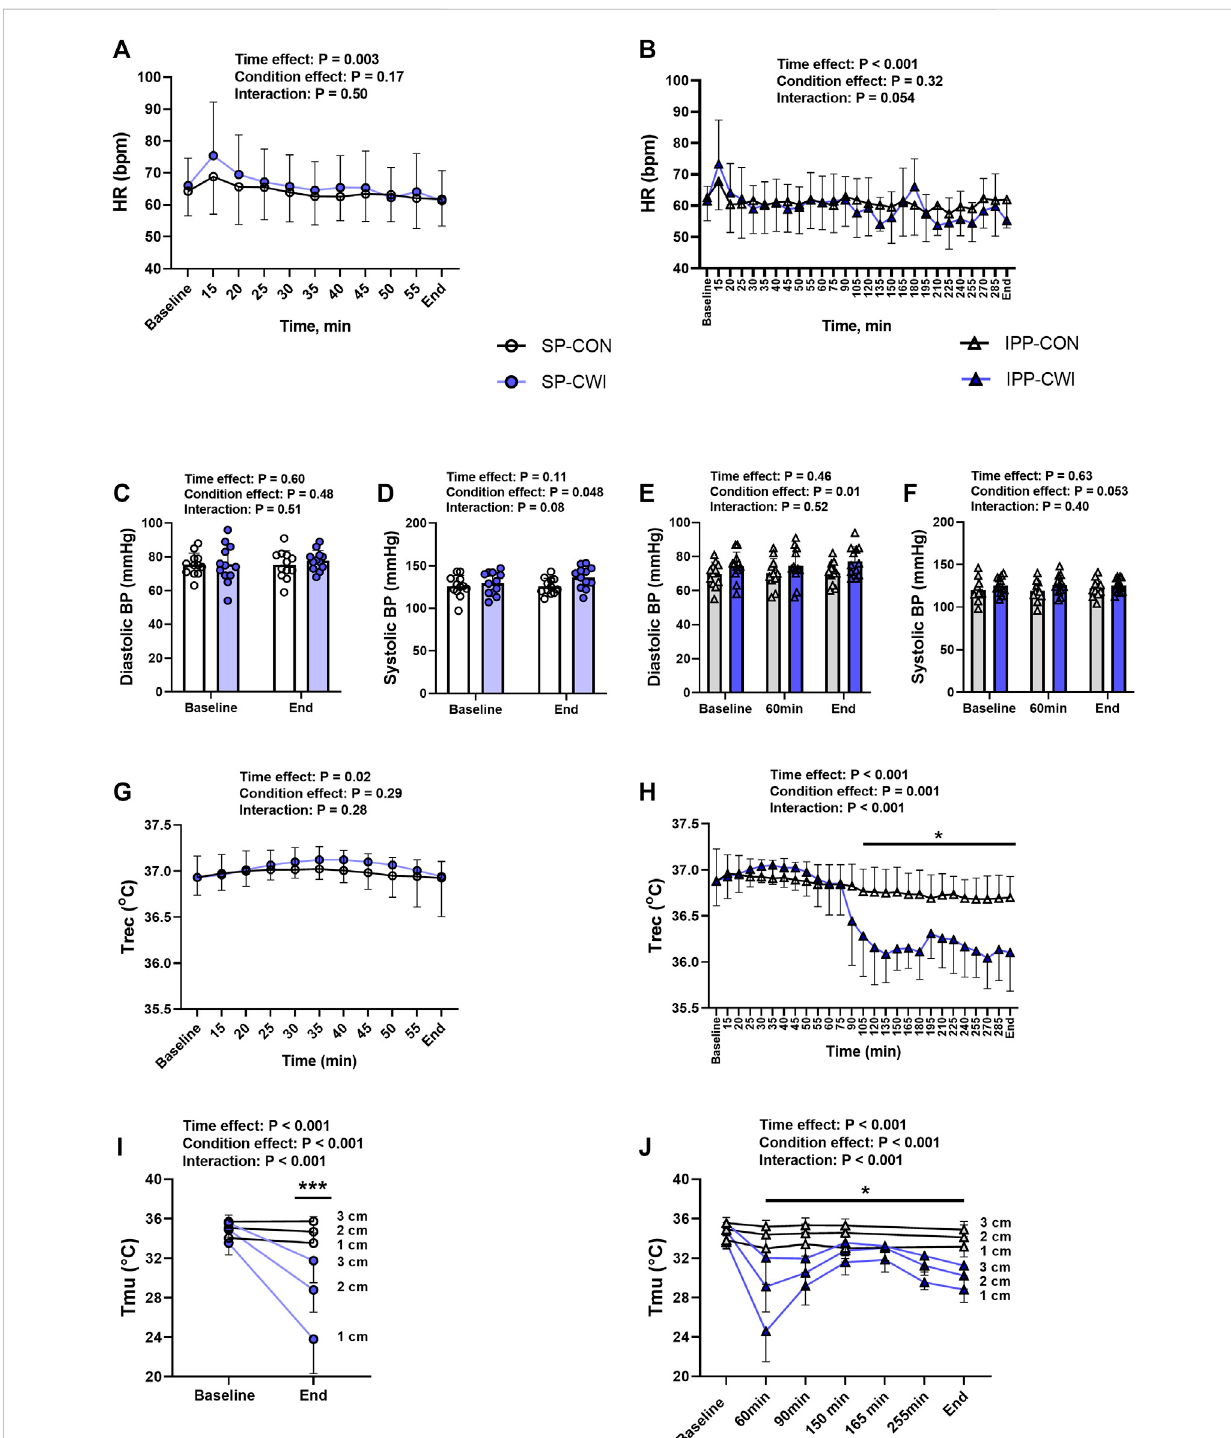
FIGURE 2 Physiologicalmeasurementsduringthesingleandintermittent/prolongedphases.Heartrate(HR) (A,B) ,diastolic (C,E) andsystolic (D,F) bloodpressures (BP), rectal temperature (Trec) (G,H) and intramuscular temperature (Tmu) at three depths (1, 2, and 3 cm) (I,J) during the single and intermittent/prolonged phases, respectively. Dataare shown asmean± SDand individualvaluesare presentedin panels C – F.SP,single phase;IPP, intermittent/prolongedphase.*, p < 0.05; ***, p < 0.001: Signi fi cant differences CON vs. CWI. In I and J, signi fi cant differences are between CON and CWI are at the three depths. In J, Tmu was not assessed in CON at the time points 165 and 255 min. N = 12 for all parameters except for Tmu (N = 11) (I,J)